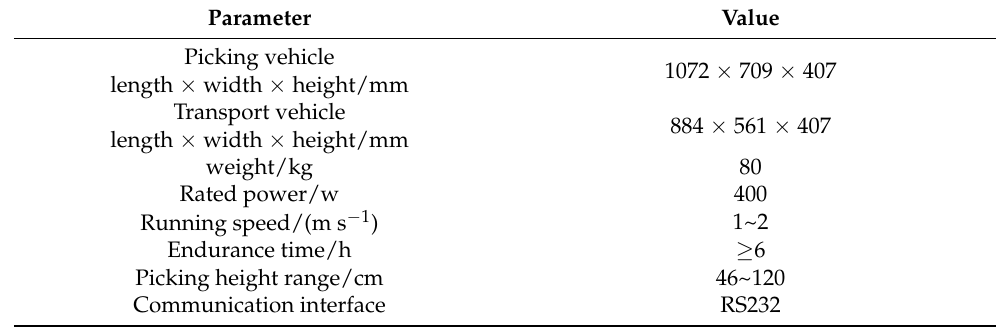
Figure 1. Whole machine structure of the tomato harvester: 1. Picking mechanism 2. Net bag mechanism 3. Conveying and collecting mechanism 4. Fork 5. Transport vehicle 6. Picking vehicle 7. Lidar module 8. Communication control module. Table 1. Main technical parameters.